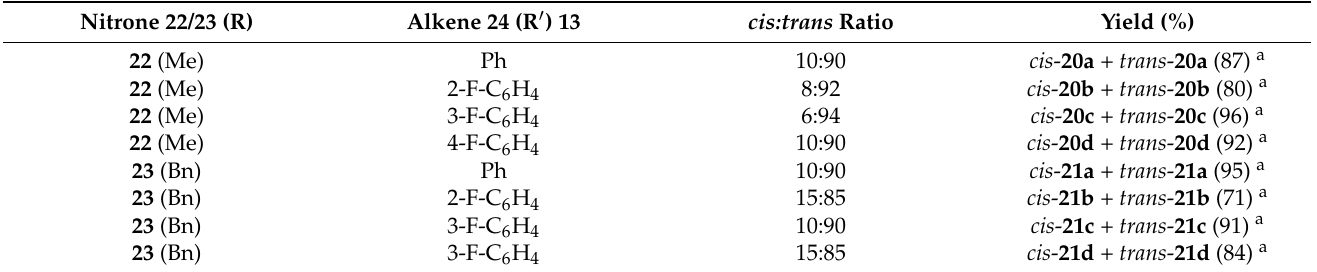
Table 1. Cycloadditions of the nitrone 22 / 23 and N 3 -allyl- N 1 -benzylquinazoline-2,4-diones 24a–d